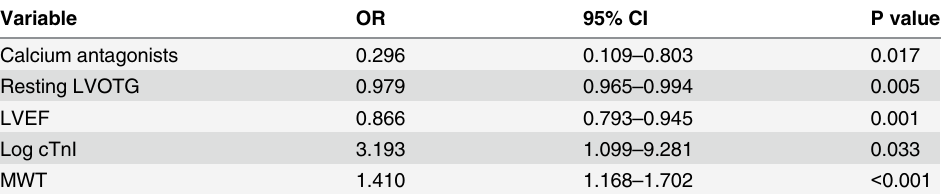
CI indicates con fi dence interval; cTnI, cardiac troponin I; LGE, late gadolinium enhancement; LVEF, left ventricular ejection fraction; LVOTG, left ventricular out fl ow tract gradient; MWT, maximum wall thickness; and OR, odds